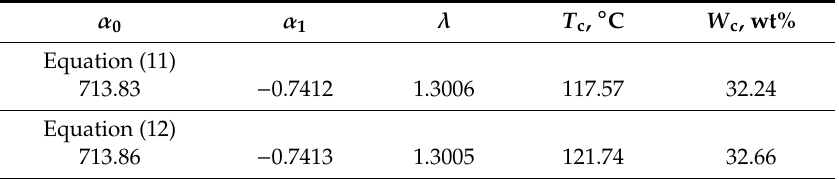
Table 2. Best fit parameters for the compound Z – methanol / water system estimated through fitting the experimental data of Bhamidi et al. [11]. Parameters obtained using both the models for the first perturbative term of the Helmholtz free energy (i.e., η e ff through Equations (11) and (12)) are listed. Also given are the estimated critical temperature ( T c ) and critical concentration ( W c ). The calculations were performed with σ = 0.664